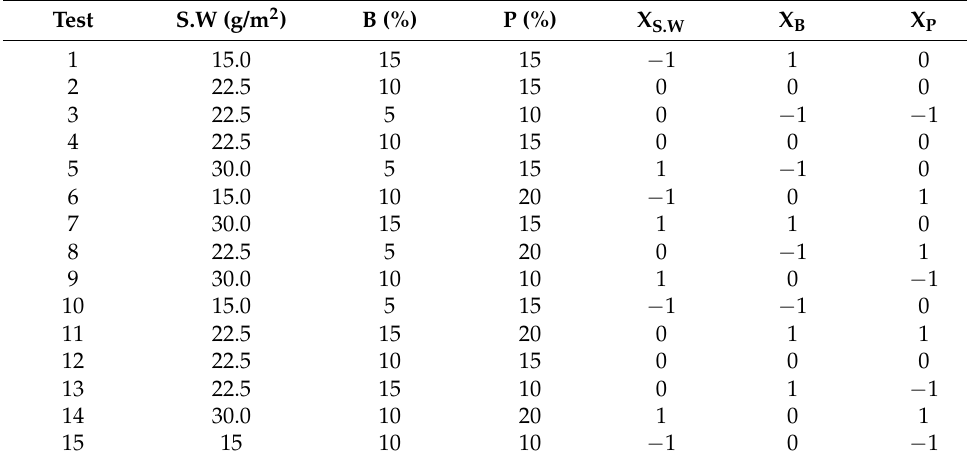
Table 3. Absolute and normalized values of the operational variables.